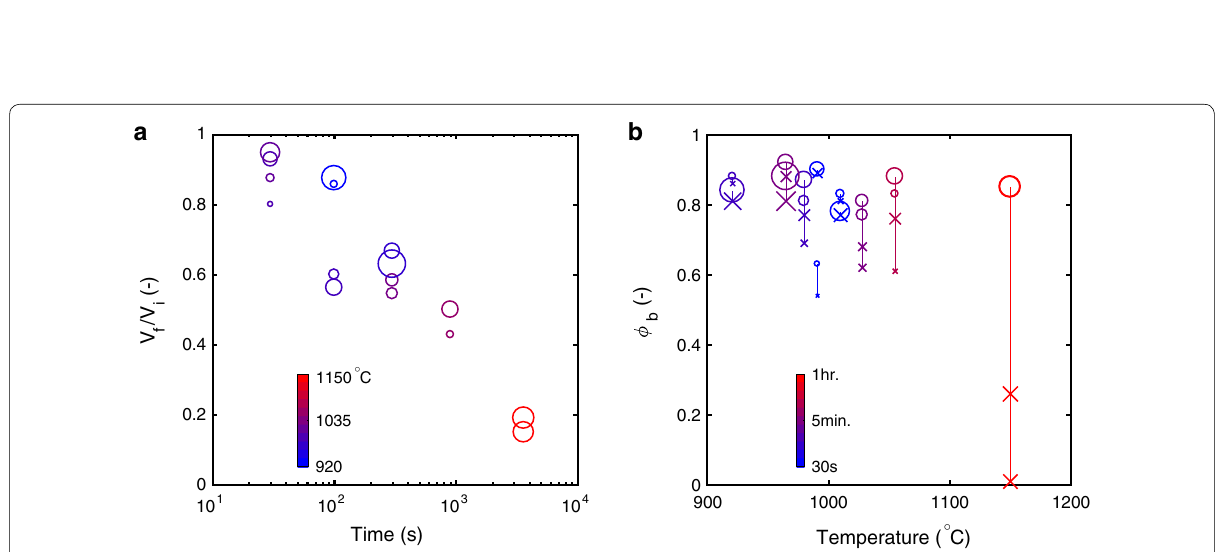
Fig. 5 Measured shrinkage due to heating. a The volume ratio of scoriae after ( V f ) to before ( V i ) heating as a function of the heating duration. The symbol color indicates the furnace temperature at the end of heating, and the symbol size indicates the initial volume of the scoria. b The porosity change due to heating. Each set of circles and crosses connected by a line indicates the porosity change of a scoria before and after heating, respectively, as a function of the furnace temperature at the end of heating. The symbol color indicates the heating duration, and the symbol size indicates the initial volume of the